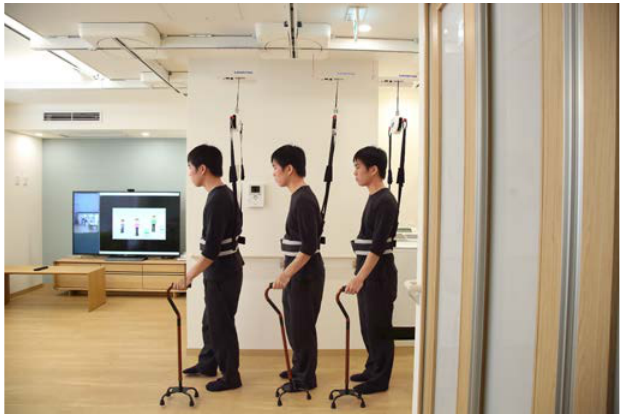
Figure 2 Example of a suspension-type system (walking support robot, Moritoh Co., Ltd.) This system is used to prevent falls while walking. The electric turntable system on the ceiling guides users in the desired direction by